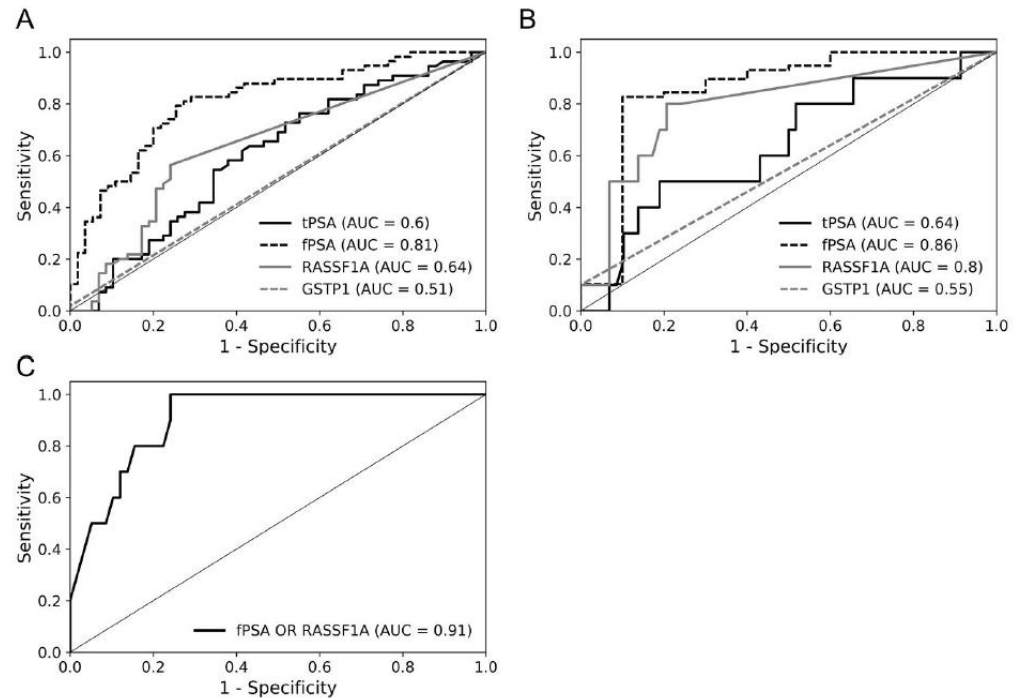
Figure 6. ROC curve analyses of RASSF1A and GSTP1 DNA methylation as well as tPSA and fPSA in different PCa subgroups compared to BPH patients. PCa and BPH cohorts were selected to include patients with tPSA values between 2.0 and 10 ng/mL, where further diagnostic validation is most crucial. Area under the curve (AUC) values are indicated in figure legends. ROC curve analyses were performed by comparing PCa patient cohorts with low Gleason scores (GS) ≤ 7 (( A ), n = 55) or high GS ≥ 8 (( B ), n = 10) with the BPH patient group ( n = 58), respectively. ( C ) Comparing high GS PCa patients with the BPH cohort, a combination of fPSA and RASSF1A methylation percentage resulted in an increased AUC of 0.91 compared to both markers alone.